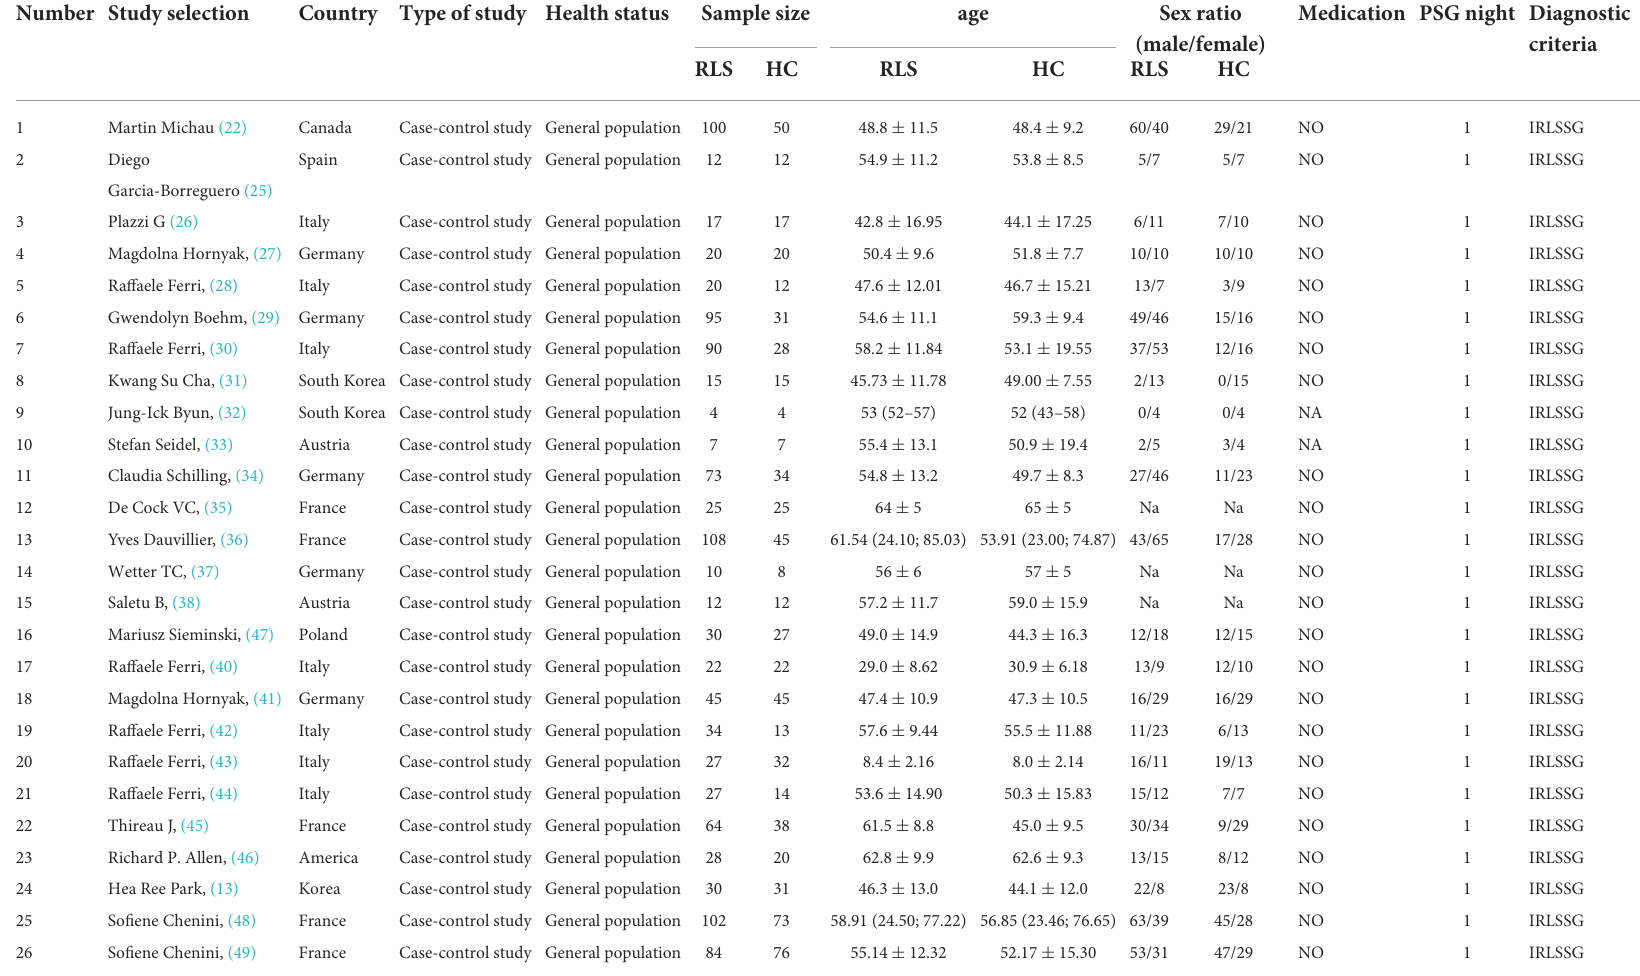
TABLE 1 Characteristics of participants included in the